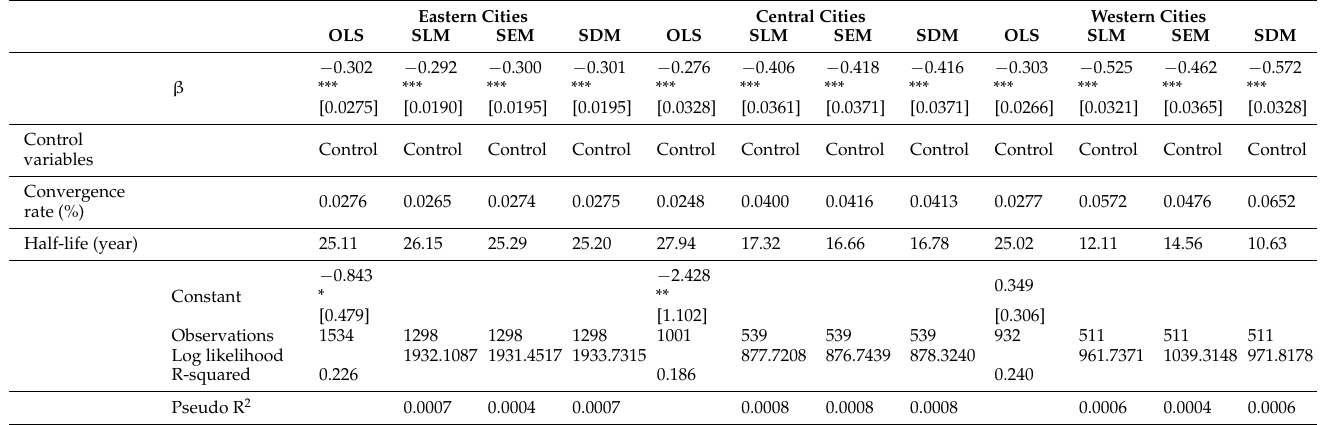
Table 6. Convergence analysis of different